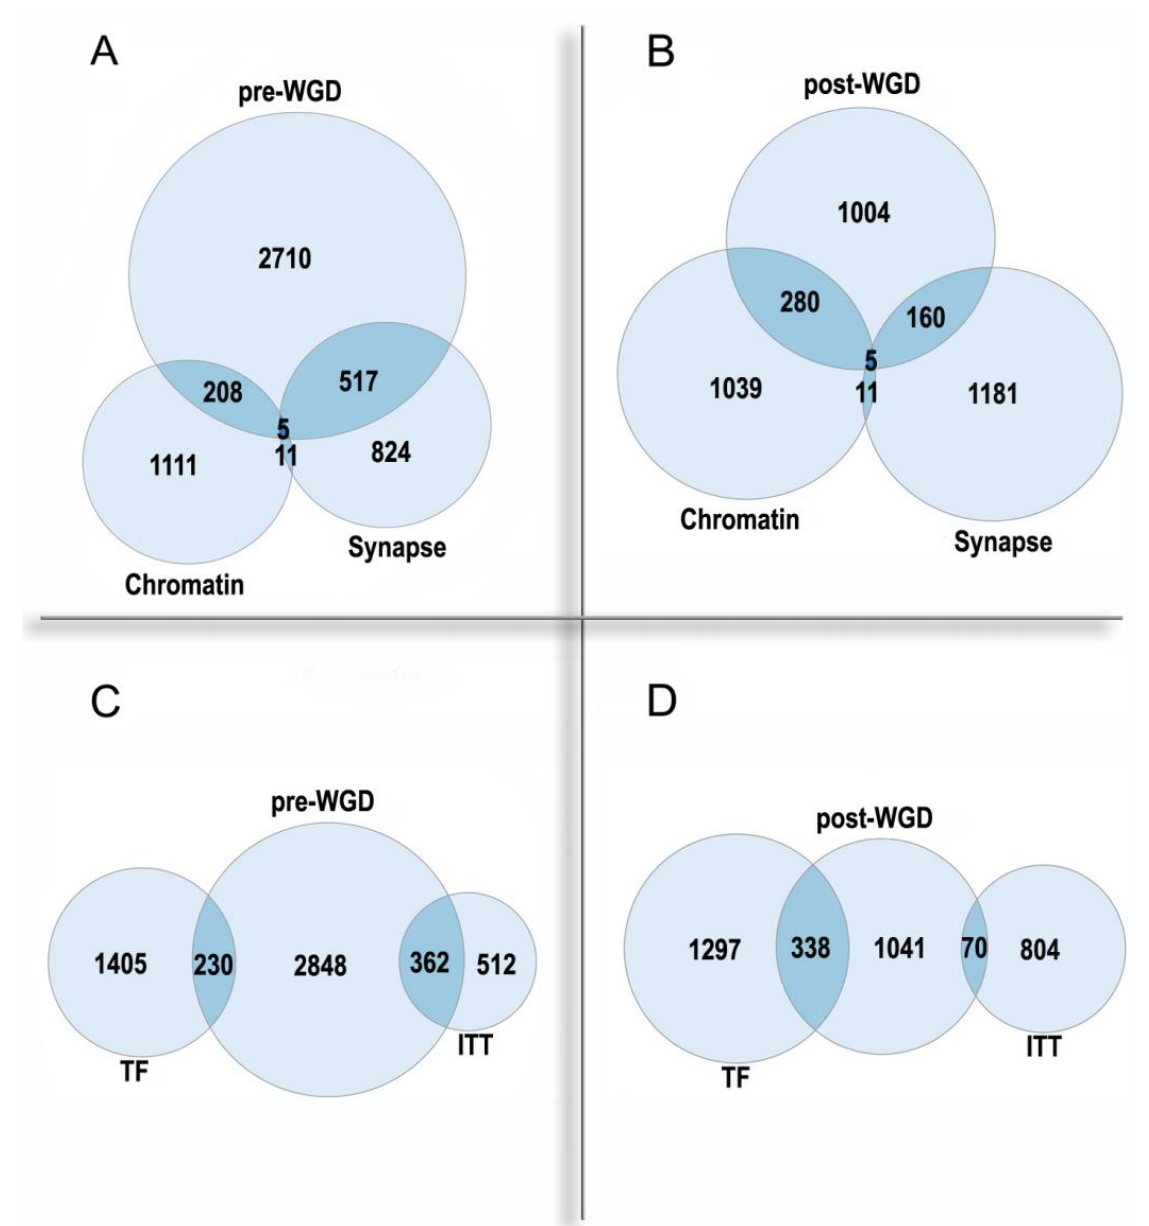
Figure 1. The enrichment of human ohnologs in bivalent genes and genes involved in multicellular organism development GO:0007275. Bivalent: p < 10 −151 , development: p < 10 −67 . The ohnologs (strict) were from [14]. The bivalent genes (Fantom-confirmed) were from [30]. The enrichment analysis was conducted as in [32].